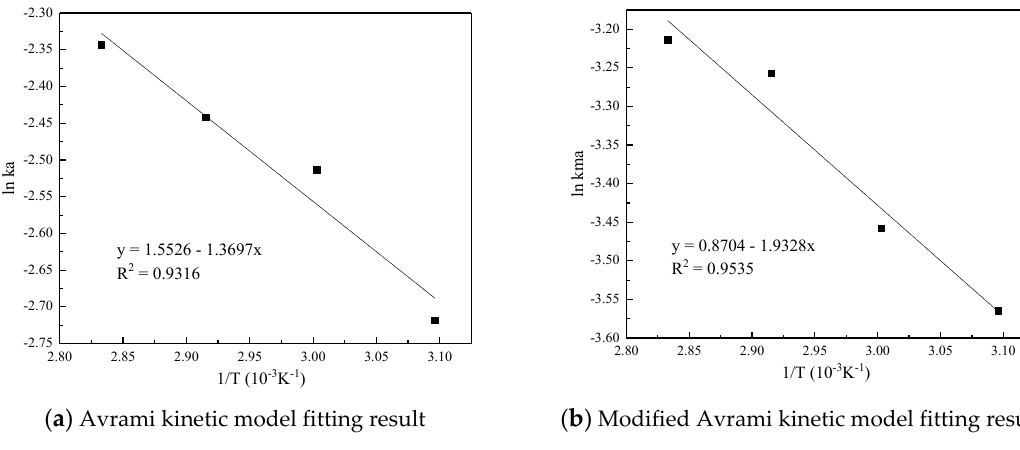
Figure 7. Linear fitting of the CO 2 adsorption on the adsorbent by Arrhenius equation. Table 5. Arrhenius equation parameters